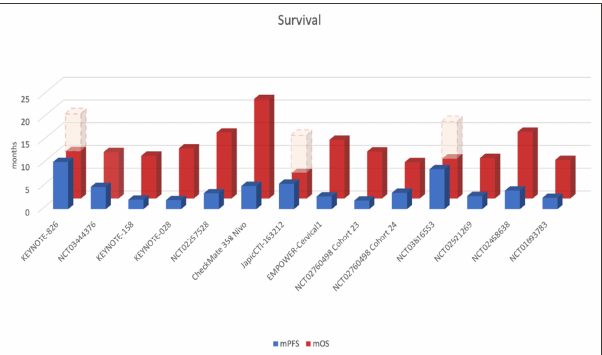
Figure 3. Survival of the included studies. Median progression-free survival (mPFS–blue bar) and overall survival (mOS– red bar ) of the included studies are reported. A total of 13 studies reported mPFS that ranged from 2 to 10.4 months. mOS was reported by 14 studies and ranged from 8 months to not reached ( dashed lines indicate ‘not reached’ values ).